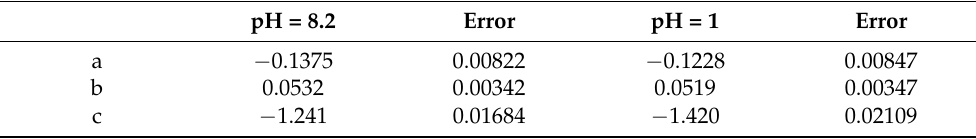
Figure 12. Potential–time curves friction electrode test carried out when the pH was 1 and 8.2 for ( a ) all periods of the test and ( b ) the last peak marked in ( a ). Table 5. Fitting parameters of the growth curve of the passive film when pH was 8.2 and